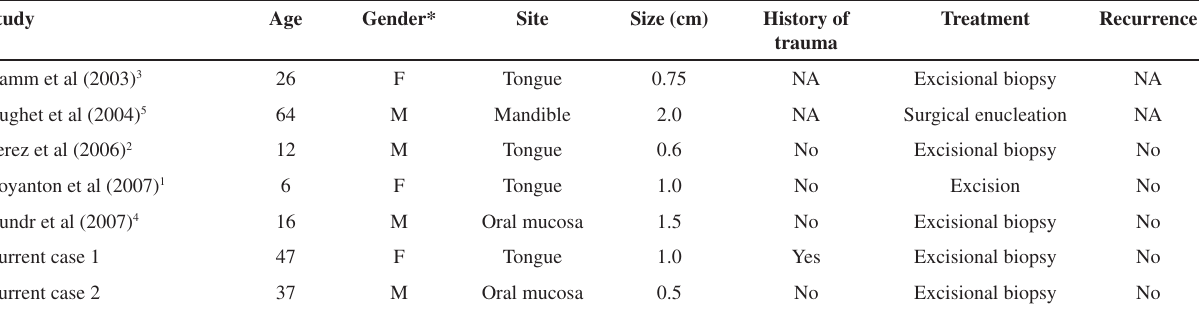
Table 1 - Summary of the reported cases of oral intraneural perineurioma, including the present cases